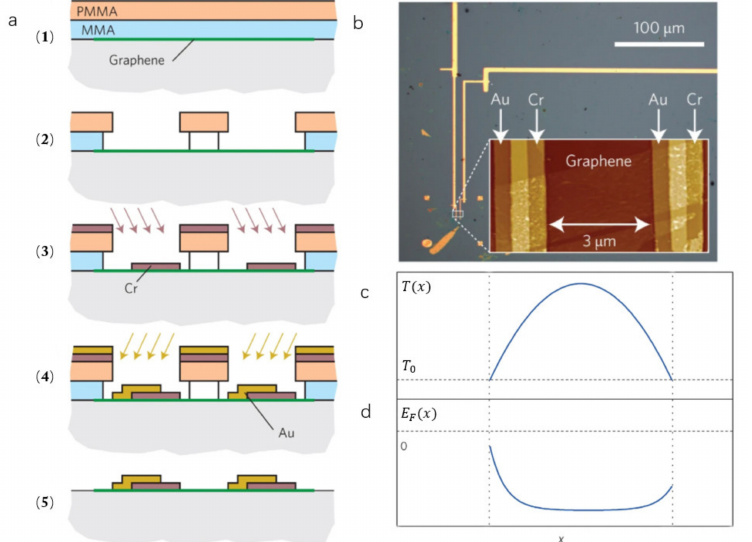
Figure 5. ( a ) Schematic illustration of the manufacturing mechanism of the detector with double angle evaporation technology. (1) MMA/PMMA is spun onto graphene. (2) Resist is patterned by an electron beam and developed. Successive angled evaporations of chromium (3) and gold (4) followed by liftoff produces a single-layer graphene device with dissimilar metal contacts on the opposing sides as shown schematically in (5). ( b ) The image of the electrical connection point of the detector in an optical microscope. ( c , d ) The curve of temperature (T (x)) and Fermi level (E F (x)) at different positions in graphene. Reprinted with permission from ref. [74]. Copyright 2021 Copyright Clearance